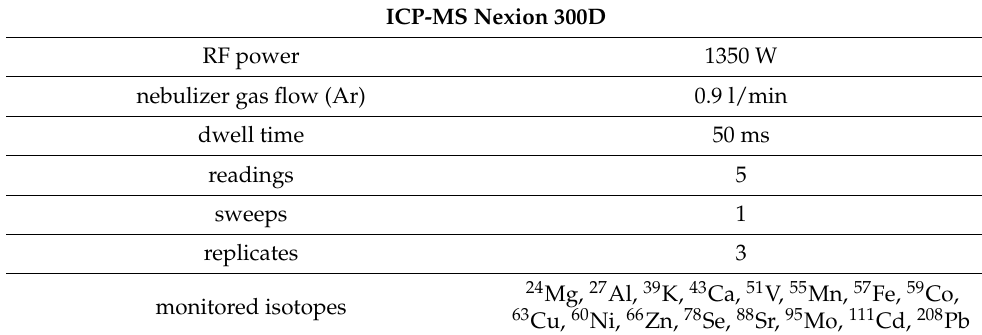
Table 3. Instrument